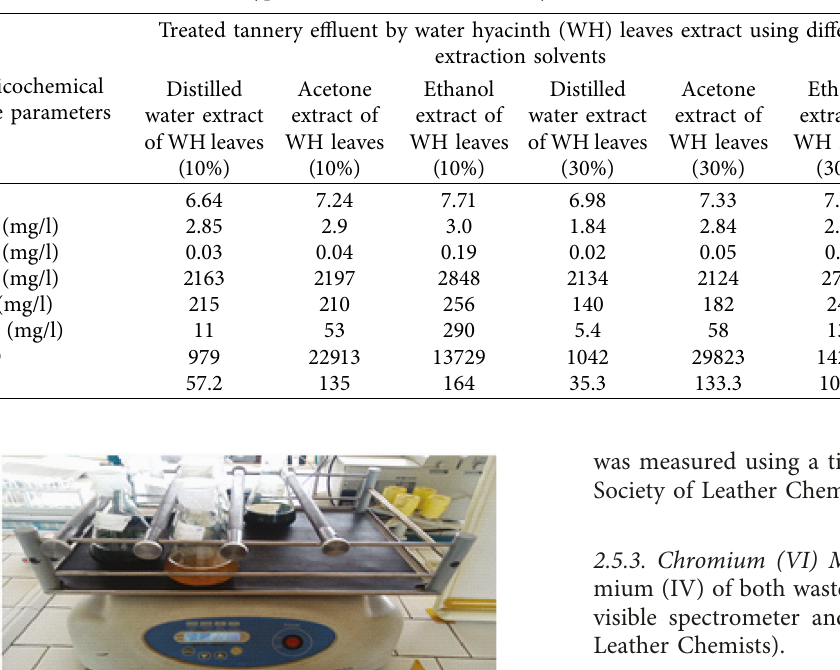
Table 1: The typical characteristics of Tannery wastewater (control) and treated tannery effluents.